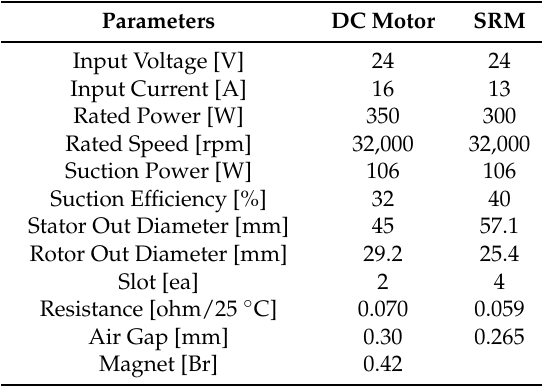
Table 1. Specifications of the proposed switched reluctance motor (SRM) in accordance with the conventional direct current motor (DC motor).